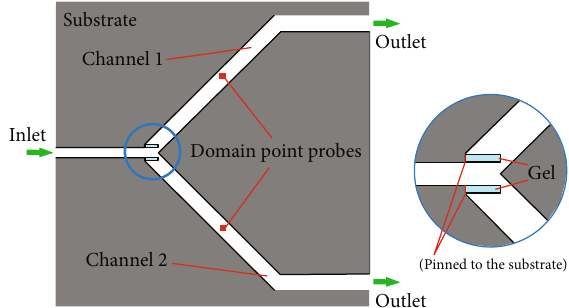
Figure 6: Oscillator computing model in COMSOL Multiphysics.